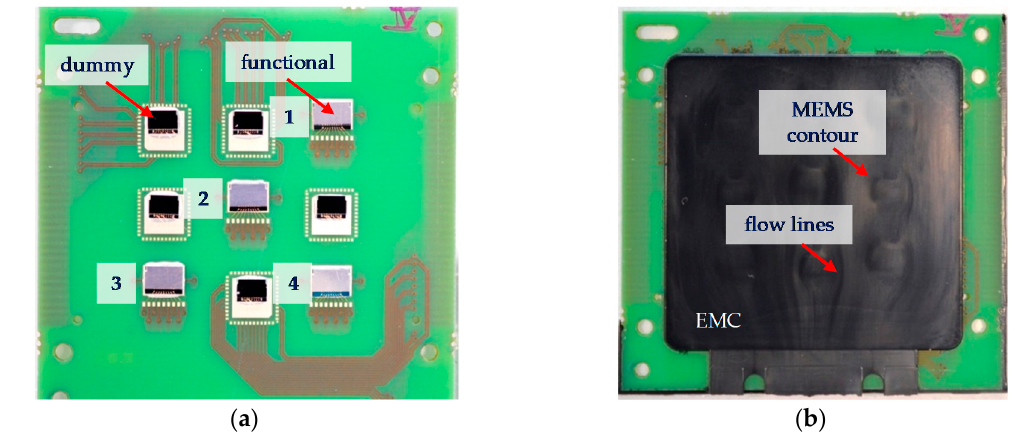
Figure 3. ( a ) Mounted inertia sensors on a PCB panel numbered from one to four and ( b ) representative image of an encapsulated panel after the film-assisted transfer molding (FAM) process.